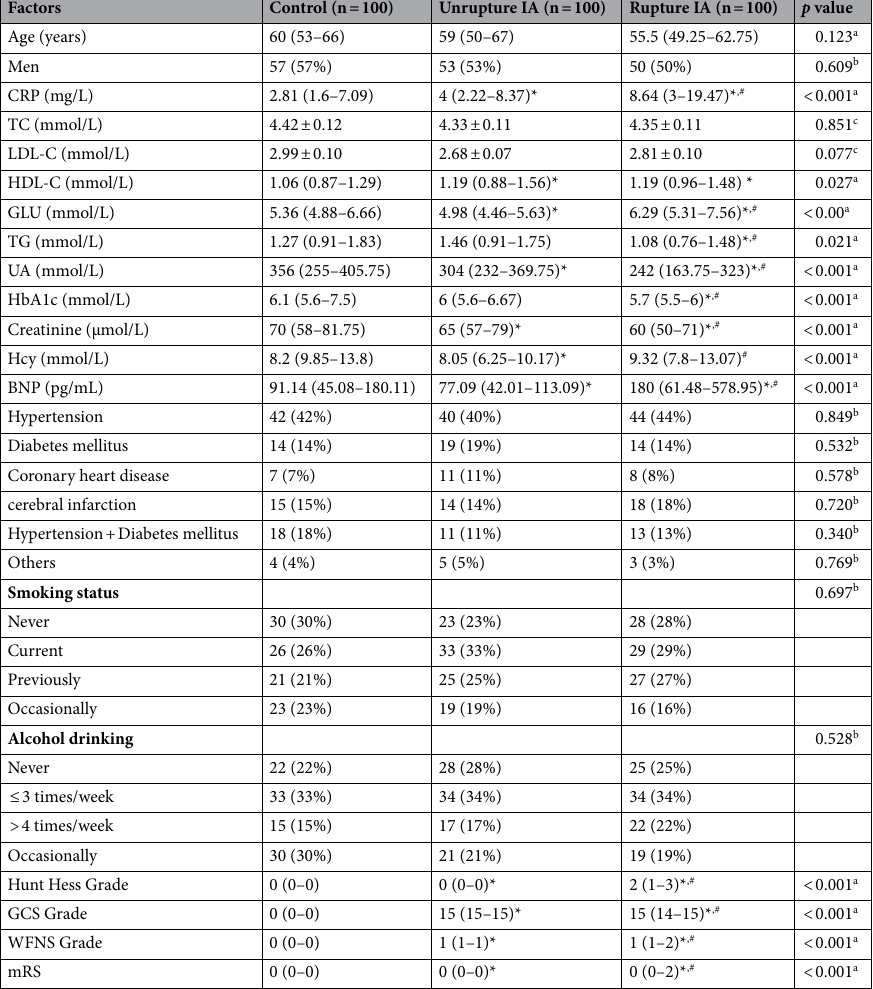
Table 2. Participants’ clinical